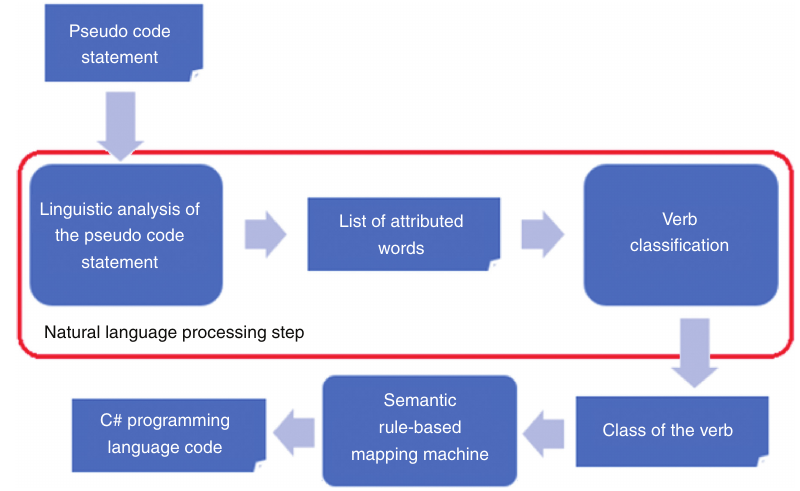
Figure 4: The Processing Flow of